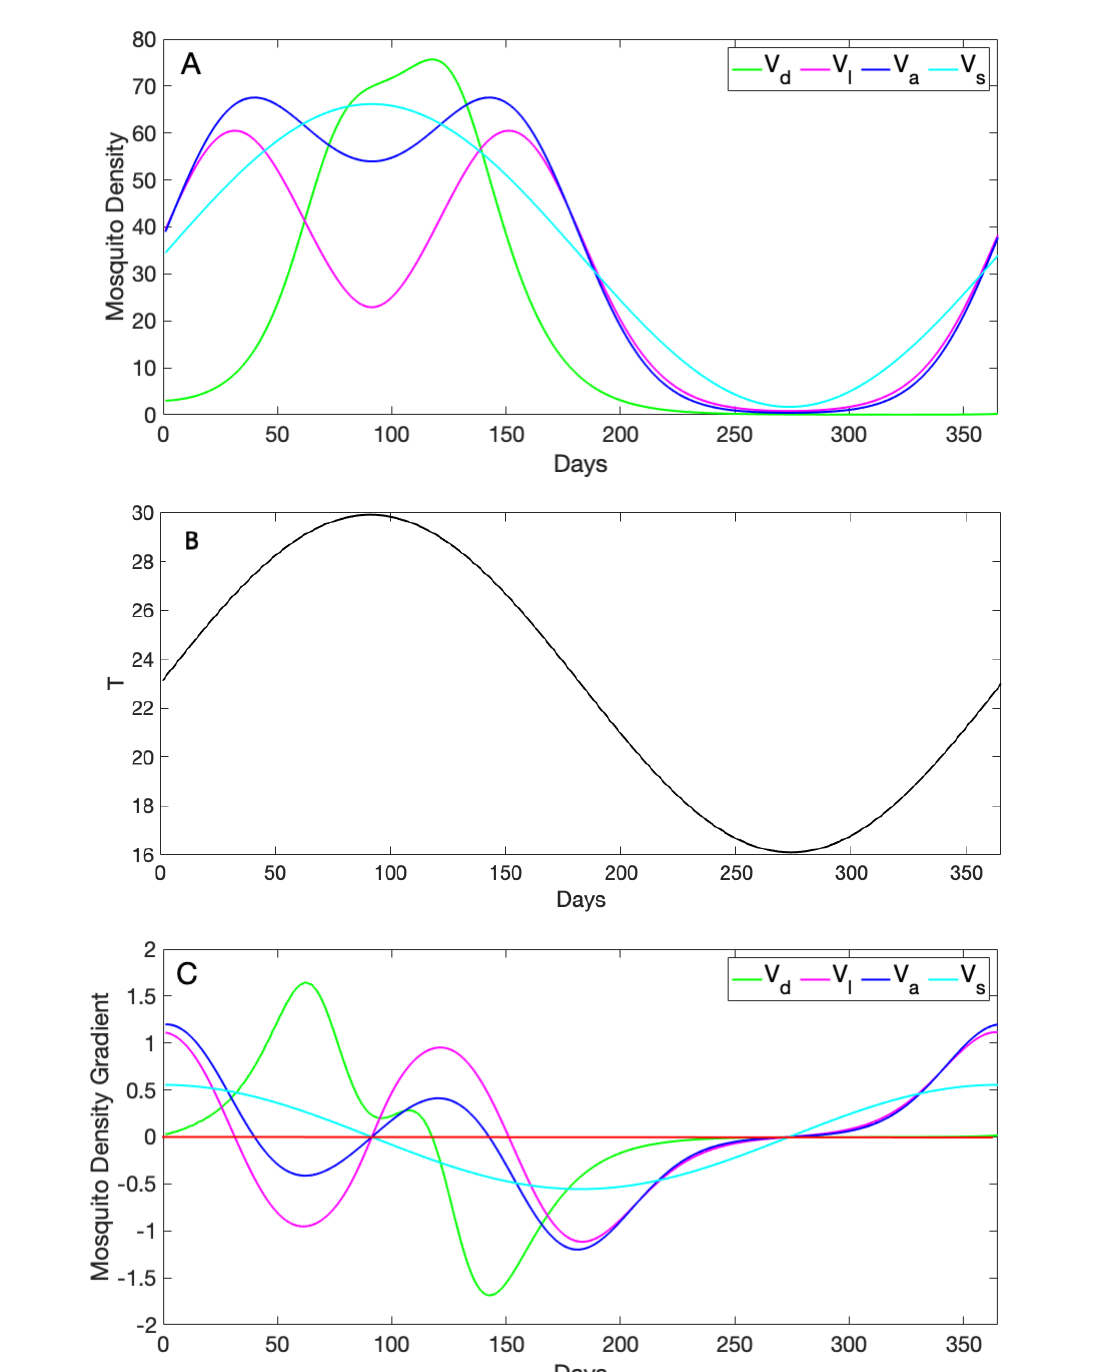
Figure 4. ( A ) Daily adult female mosquito densities approximated using four forms, namely the sine wave V s with initial V 0 = 33 and amplitude of 0.45, the adult trait-dependent form V a , the life stage trait-dependent V l , and the dynamical density V d ; the parameter values used to solve the ode model are given in Table 1. ( B ) Daily temperature given by a sine function ( T 0 ( 1 + B sin ( 2 π t /365 with T 0 = 23 and B = 0.3) evaluated for 365 days used to evaluate our thermal traits incorporated into the dynamical model. ( C ) Densities’ first derivatives calculated to show how each curve changes its gradient as it varies with temperature. The red line shows when the gradient is zero; positive gradient values (above the red line) mean that the density increases; and negative values of the gradient (below the red line) mean that the curve